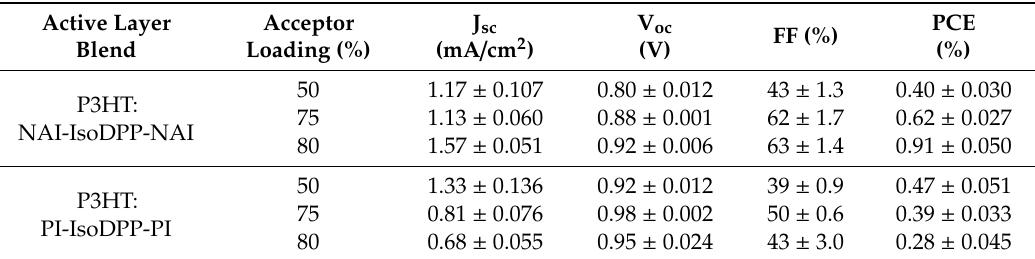
Table 2. Summary of photovoltaic characteristics of P3HT / NAI-IsoDPP-NAI and PI-IsoDPP-PI devices with varying acceptor loading, values being an average of 12